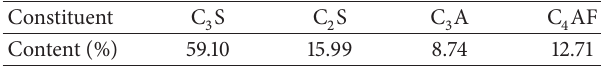
Table 1: Mineral constituents and contents of cement.